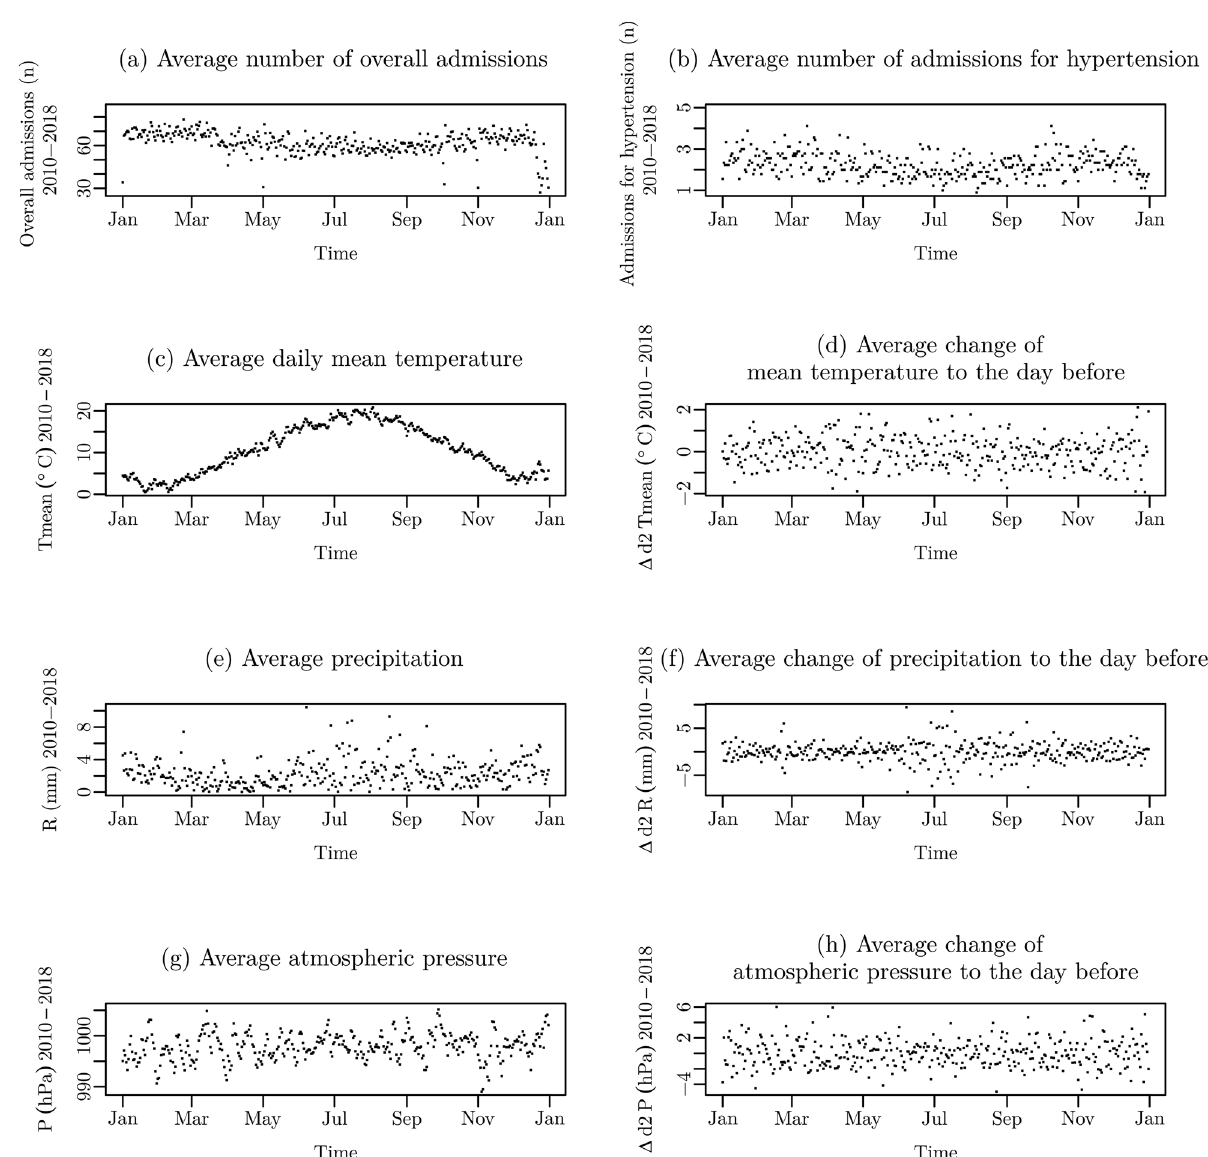
Figure 1. Mean annual course of ( a ) daily numbers of overall admissions, ( b ) daily numbers of admissions for hypertensive diseases, ( c ) daily mean temperature (T mean ), ( d ) change of temperature to the day before (ΔT mean ), ( e ) daily rainfall (R), ( f ) change of rainfall to the day before (ΔR), ( g ) daily mean athmospheric pressure (P), and ( h ) change fo athmospheric pressure to the day before (ΔP) between